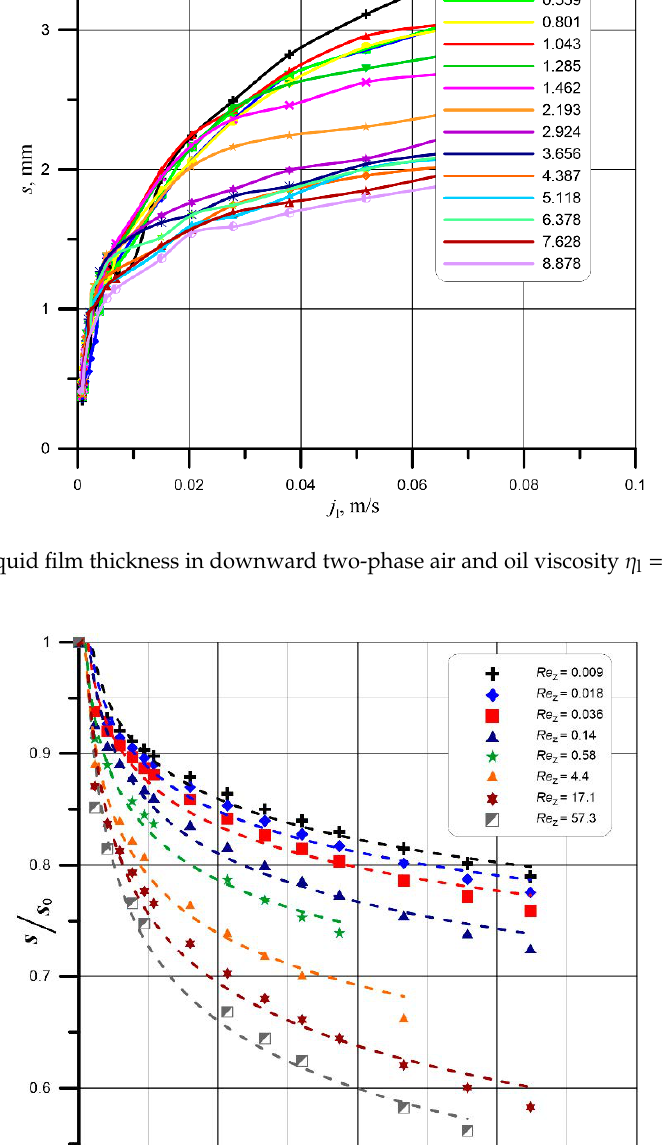
Figure 11. Exemplary study results of surface state and thickness distribution of the liquid film.